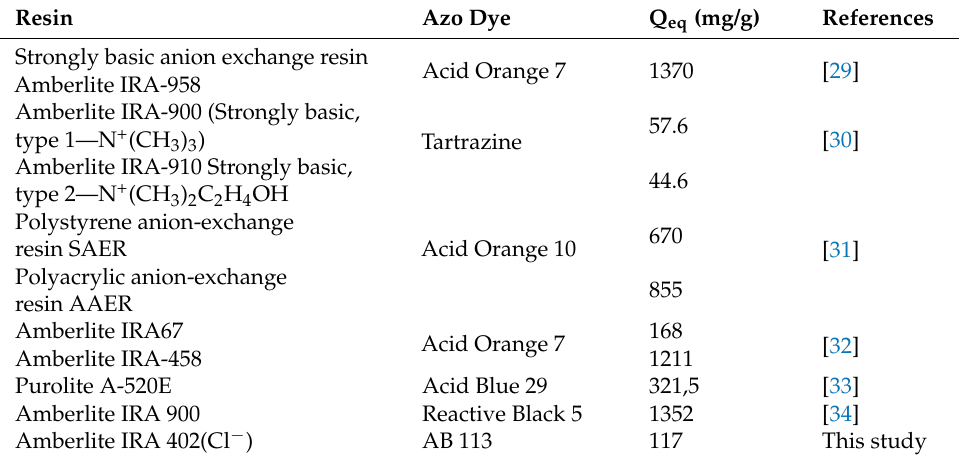
Table 2. Polymeric resin used to remove dyes from